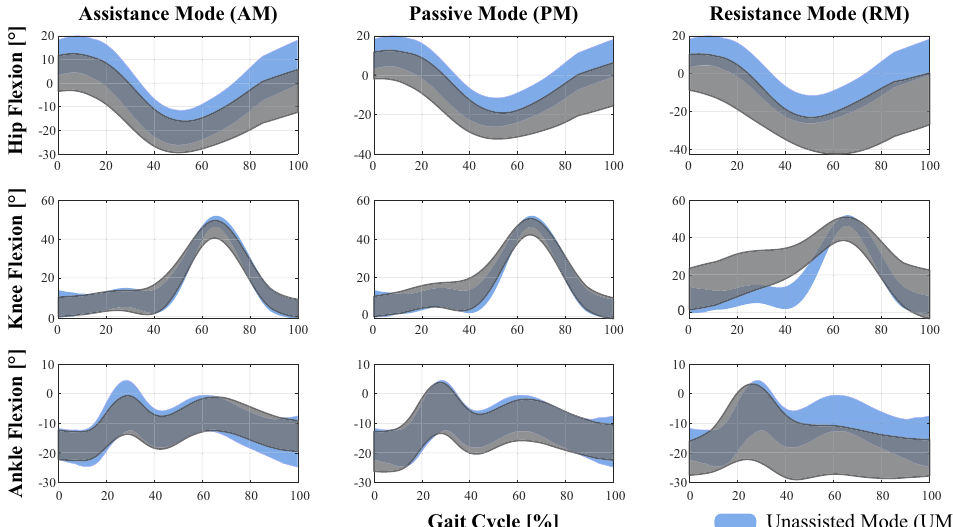
Figure 6. Comparison of sagittal plane joint angles for the assistance levels. Each graph was generated using average gait cycles and standard deviations within